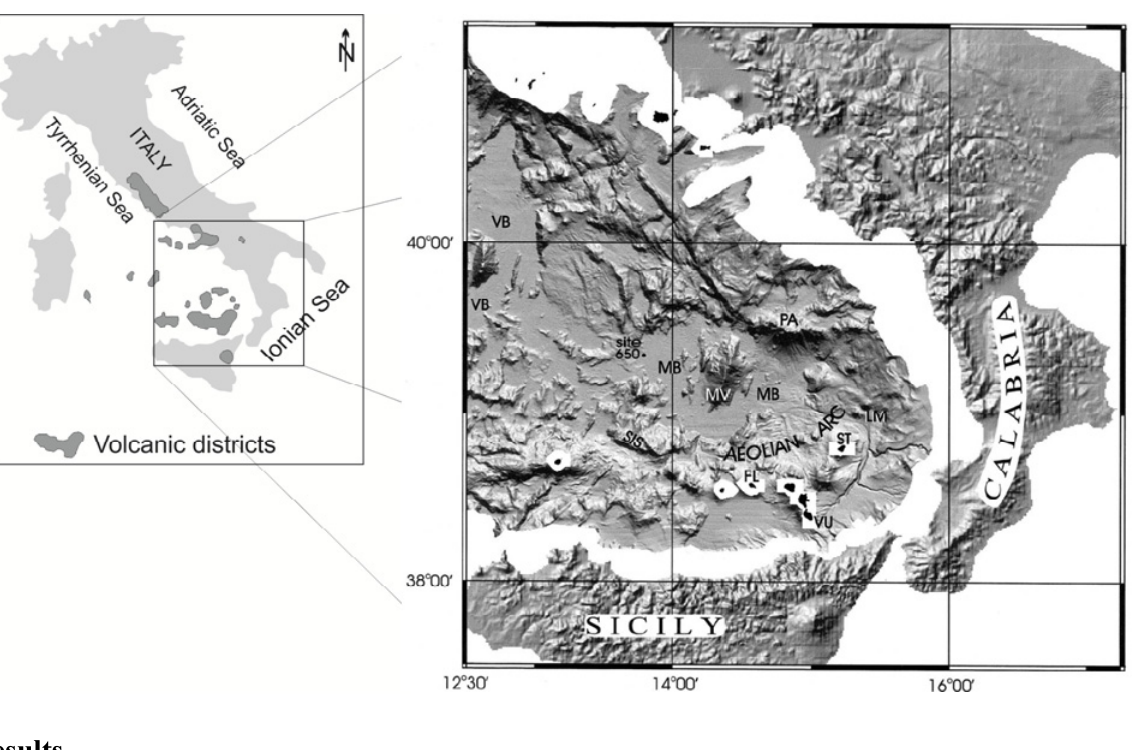
Figure 1. Location of the study area. MV: Marsili Volcano; MB Marsili Basin; ST: volcanoes of Stromboli; VU: volcanoes of Vulcano; FL: Filicudi Island; SIS: Sisifo submarine Volcanoes; LM: Lametini Seamounts; PA: Palinuro Seamount; VB: Vavilov Basin. The map on the right is modified after